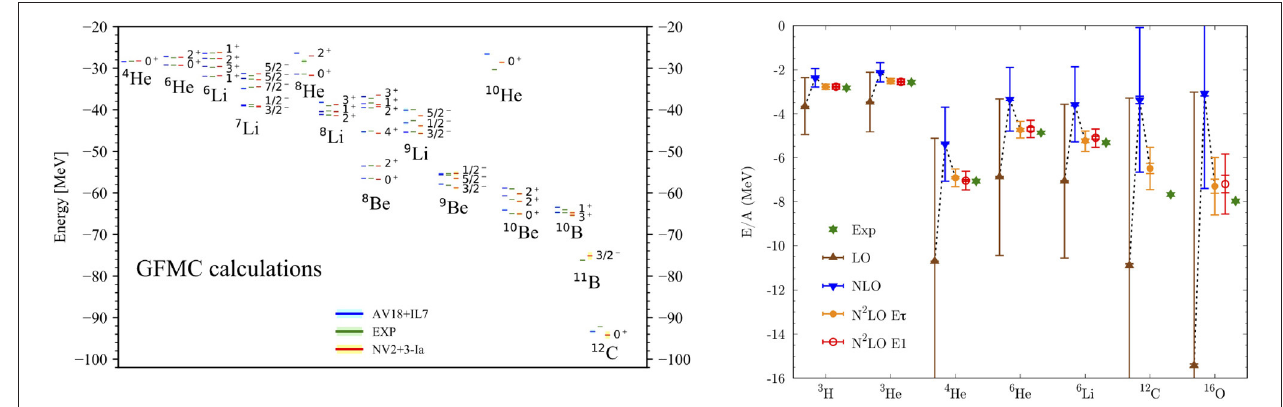
FIGURE 6 | (Left) Spectra of light nuclei up to 12 C obtained with GFMC with chiral interactions obtained in the delta-full approach (red) compared to experimental data (green) and GFMC calculations with phenomenological interactions (blue). Figure taken from Piarulli et al. [93] under the Creative Commons CCBY license. (Right) Ground-state energies for nuclei up to 16 O at different orders in the chiral expansion for AFDMC calculations with local interactions in the delta-less approach. Reprinted from Lonardoni et al. [ 99] with permission from the American Physical Society.